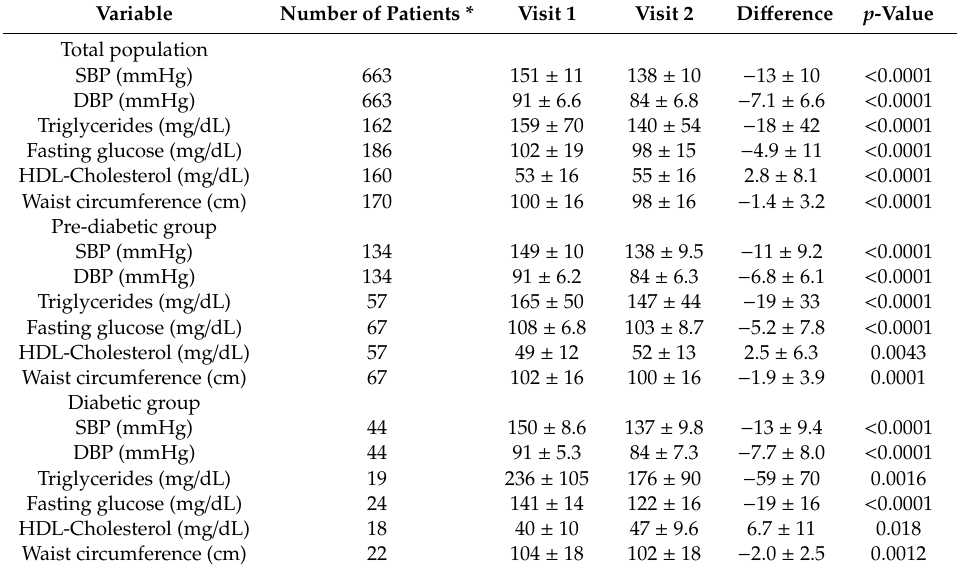
Table 3. Supplementation e ff ect on blood pressure parameters and metabolic syndrome markers in the total study population and in the pre-diabetic and diabetic